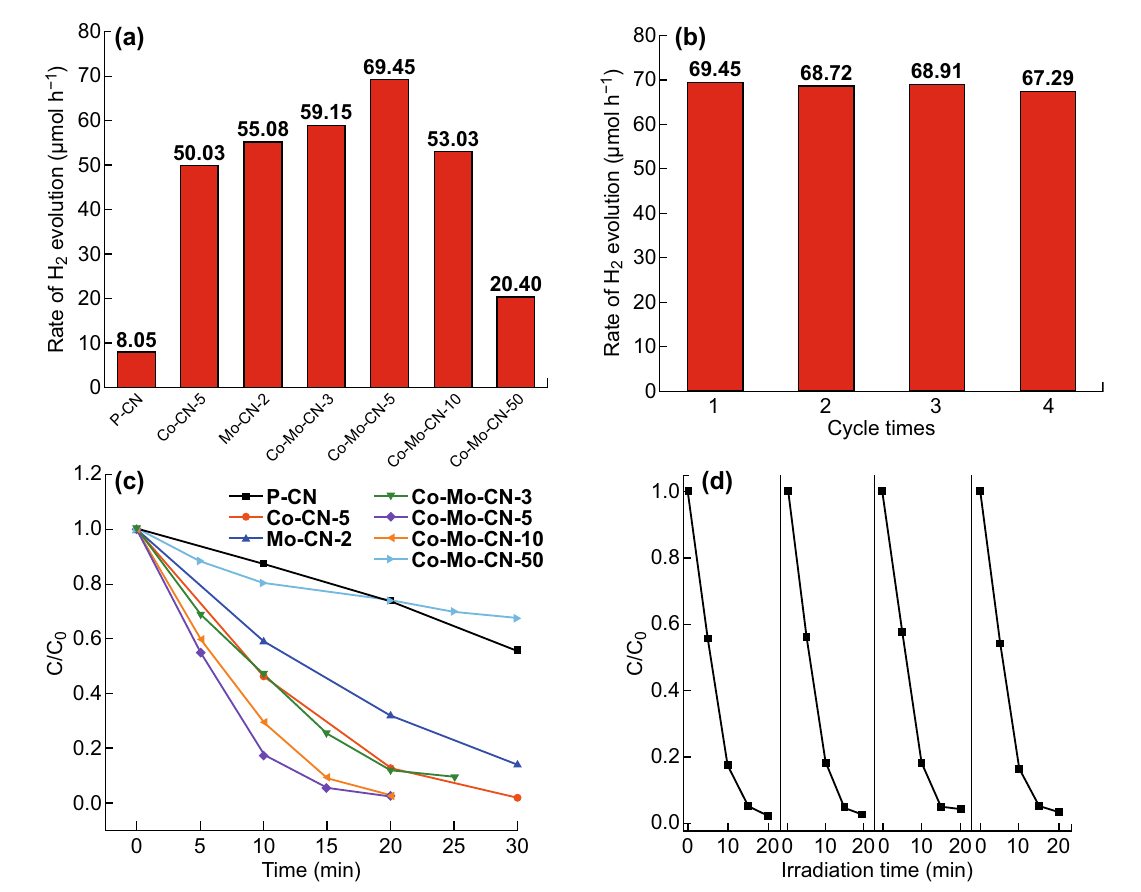
Fig. 6 a Photocatalytic H 2 evolution rate of as-prepared materials, b cyclic test of photocatalytic H 2 evolution by Co/Mo-MCN-5, c Photocata- lytic activities of RhB degradation for as-materials and d cyclic test of RhB degradation by